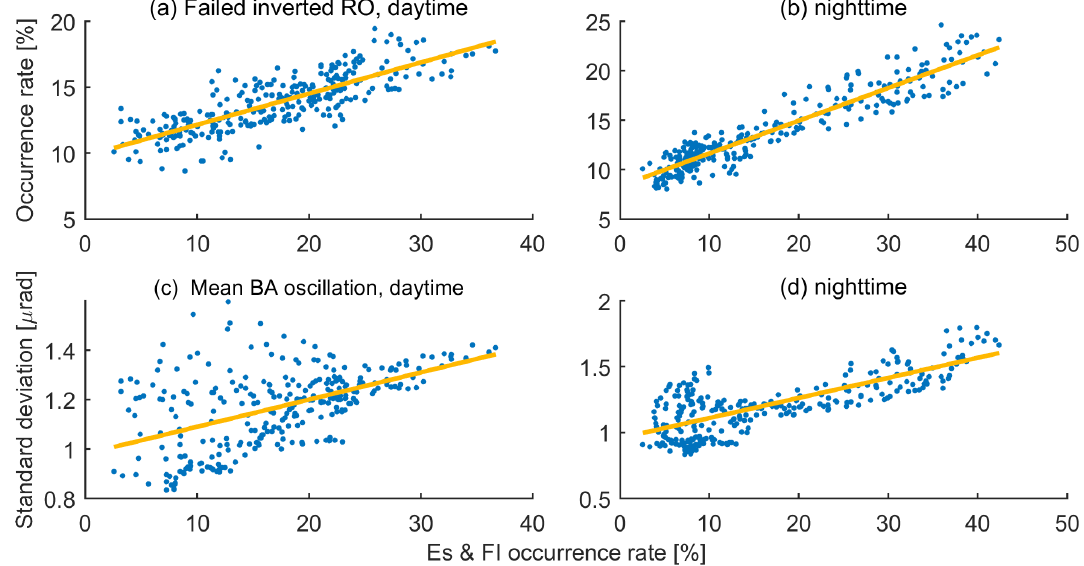
Figure 5. Correlations between the ionospheric irregularity and the two parameters at middle and low latitudes (60 ◦ S–60 ◦ N) during the daytime (06:00–18:00MLT, a, c ) and nighttime (00:00–06:00 & 18:00–24:00MLT, b, d ) of 2011–2013. The yellow line is the corresponding linear least square fitting